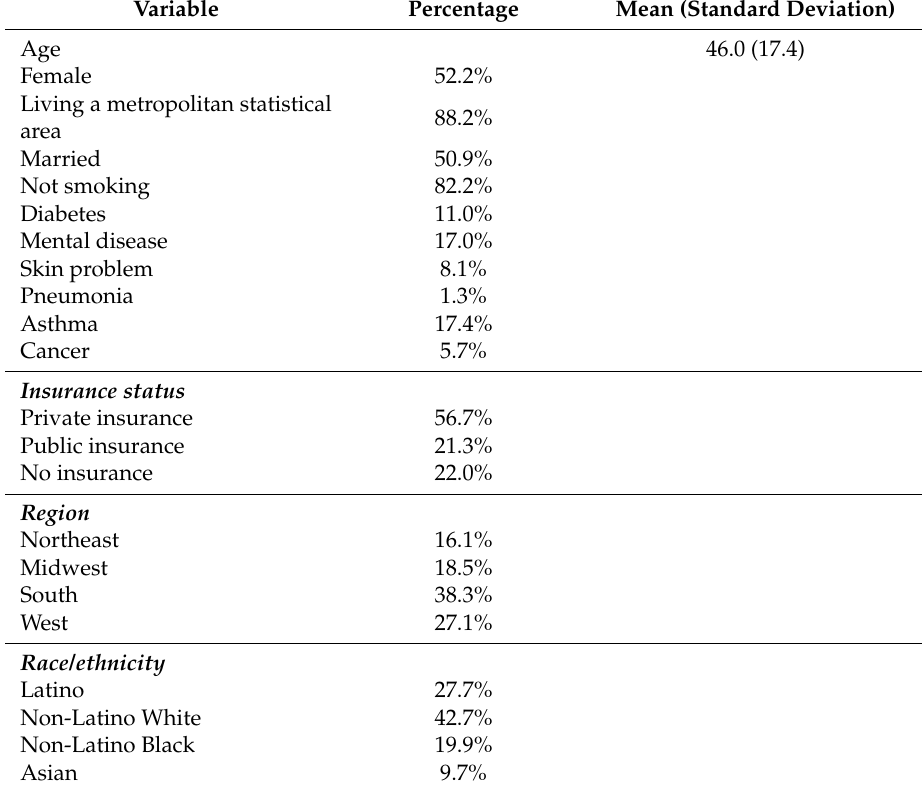
Table 1. Descriptive statistics about independent variables in the analysis sample (N =